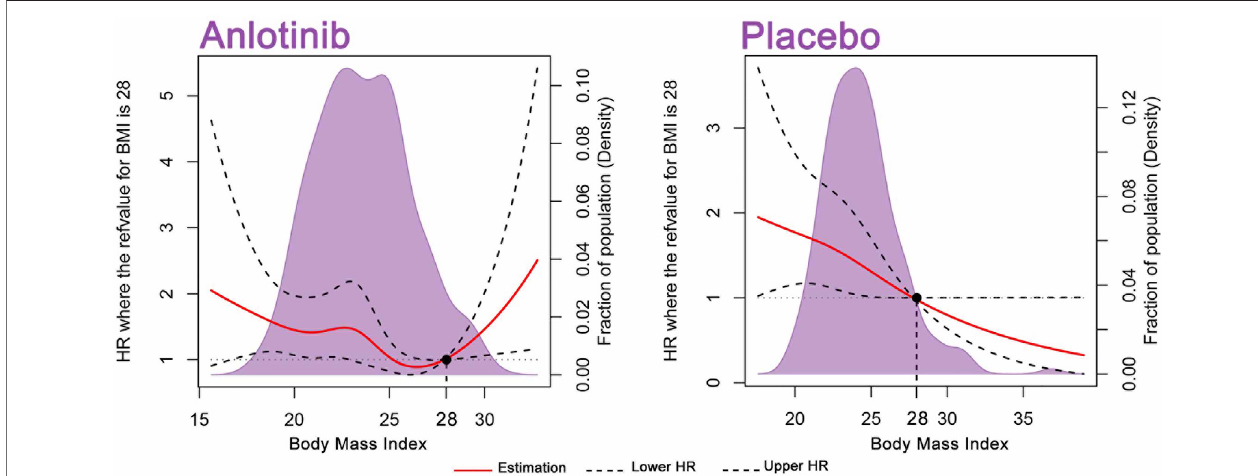
FIGURE2| BMIonacontinuousscaleandtheriskofmortalityin554patients.Analyseswereconductedusingrestrictedcubicsplines,withhazardratiosand95% con fi dence intervals from multiple-event Cox proportional hazards regression. The BMI value of28 waschosen asareference. The purple areas indicate the distribution of concentrations of BMI. Body mass index